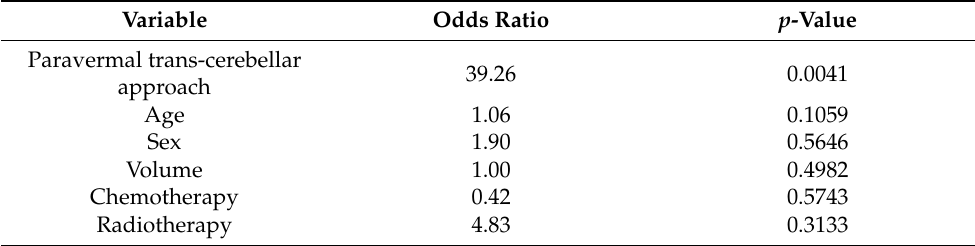
Table A1. Multivariate logistic regression. The multivariate logistic regression predicting HOD development is shown, due to partially missing information the analysis was run on n =